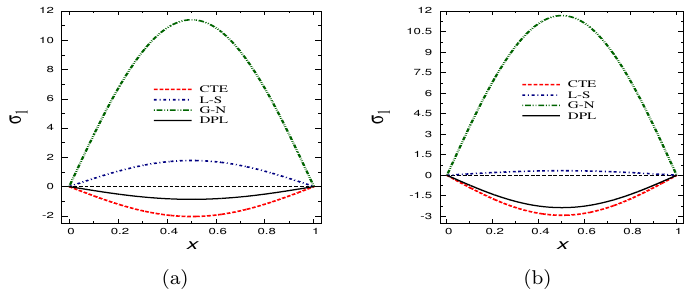
Figure 8. The axial normal stress distributions in the axial direction for beams under (a) thermal load and (b) thermomechanical load. Figure 8 shows the variation of the dimensionless axial stress σ 1 along the axial direction at the bottom surface z = − 0 . 5. The absolute maximum axial stress σ 1 occurs at the center of the beam. For the two loaded beams, the axial stress σ 1 of the G-N and L-S models still positive while those of the DPL and CTE models still negative along the axial direction. The G-N gives the highest axial stresses along the axis of the beam in the two cases. Figure 9 shows the through-the-thickness variation of the dimensionless axial stress σ 1 at the center of the beam x = 0 . 5. The G-N model may be failed to get accurate axial stress. Other models may be closed to each other. The DPL model gives tensile Math. Model. Anal., 21(3):319–335,